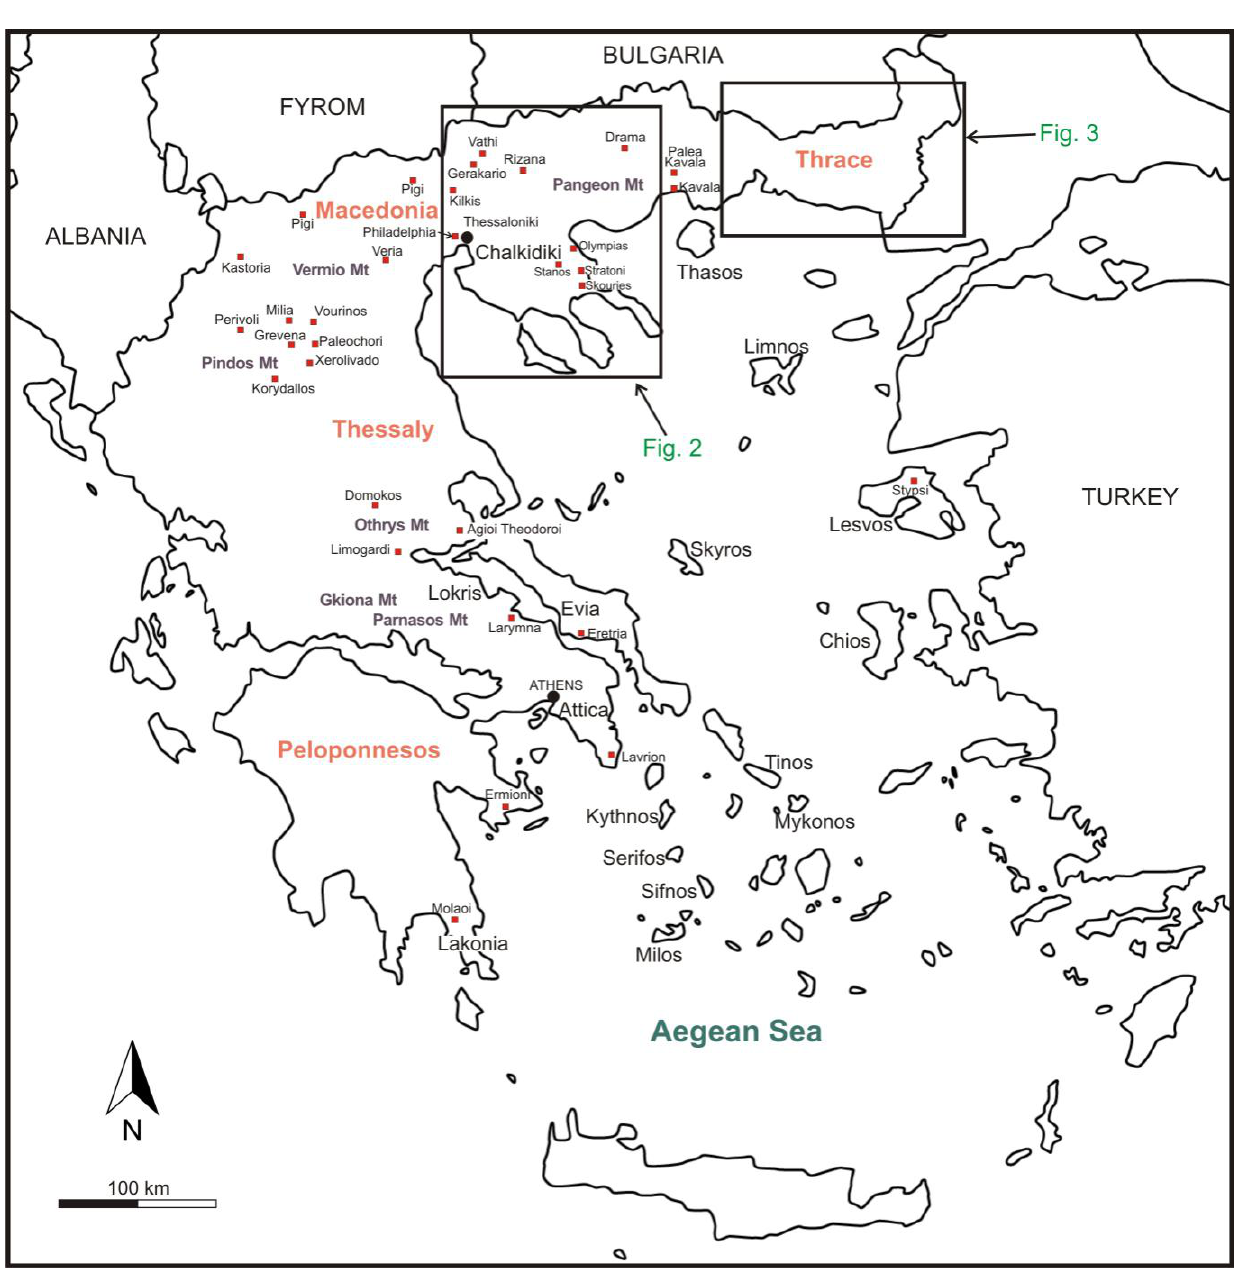
Figure 1. Map of Greece with the distribution of the most significant ore deposits. The ore deposits of Thrace are displayed in Figure